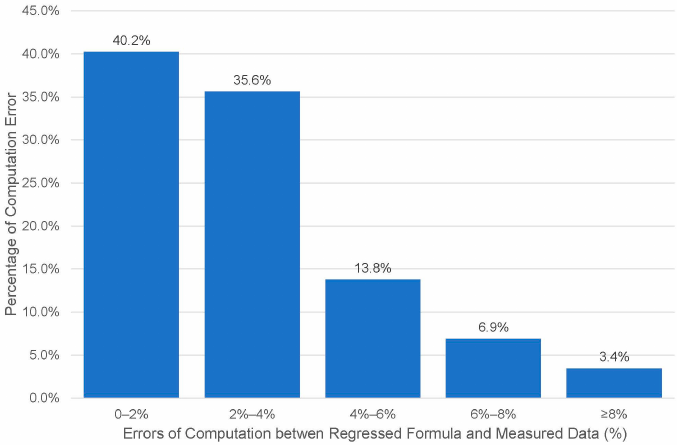
Figure 10. Distribution of computation error between the regressed model and measured data.